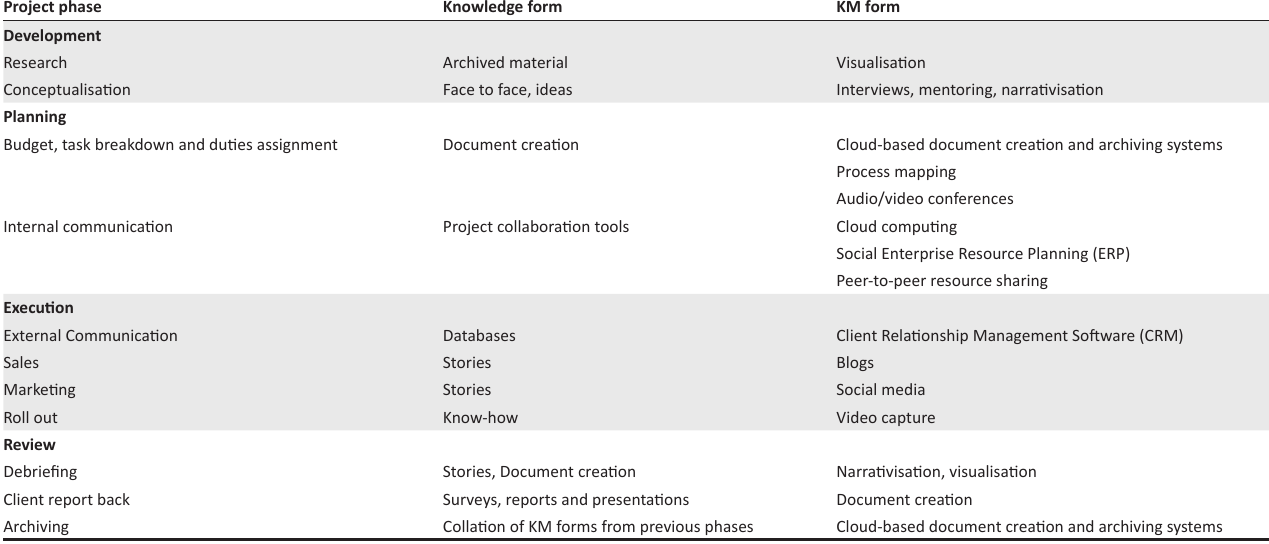
TABLE 2: Knowledge management in the project lifecycle. Project